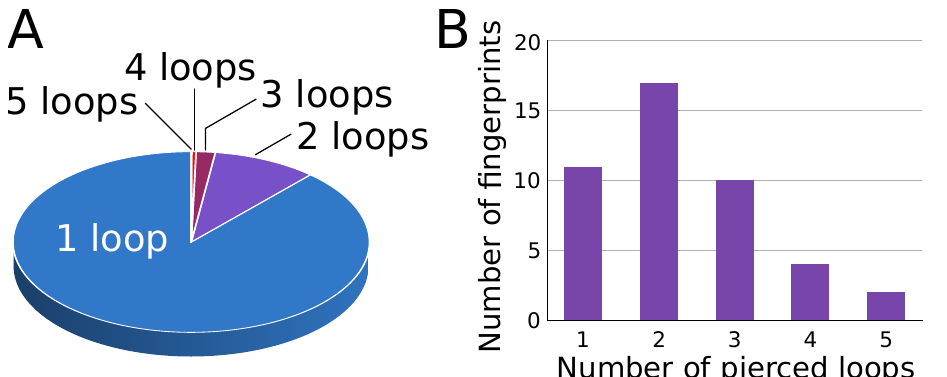
Figure 6. Distribution of pierced loops and lasso fingerprints in lasso proteins. ( A ) Number of pierced loops in a single chain. ( B ) Number of different lasso fingerprints depending on the number of pierced loops.